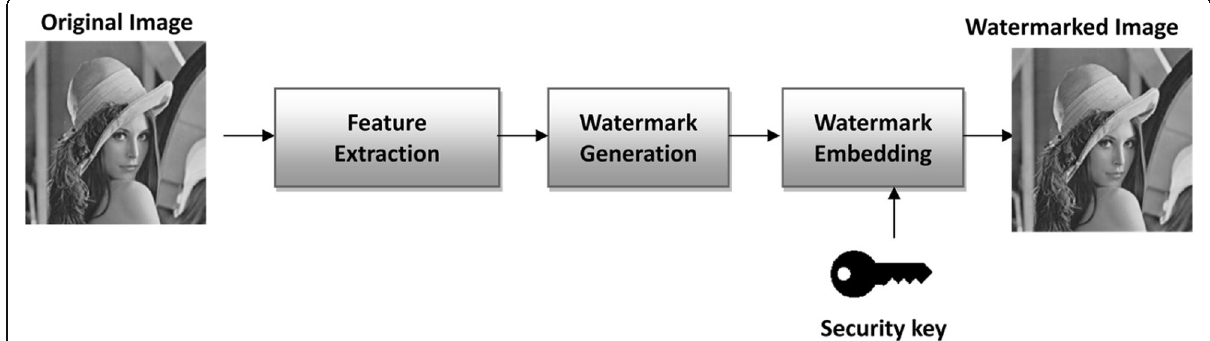
Fig. 2 Block diagram of watermark embedding